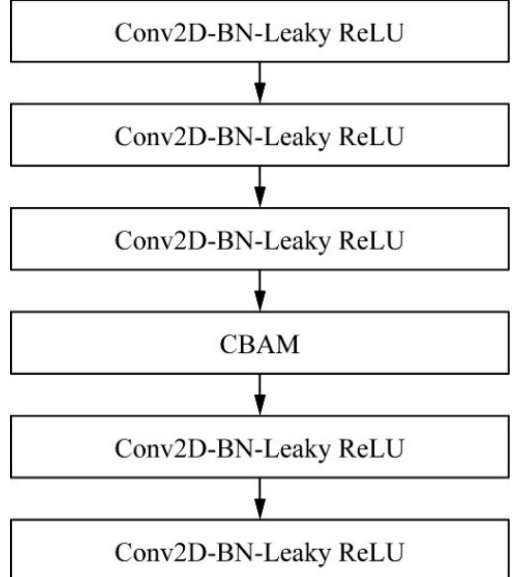
Figure 9. CBC module figure.